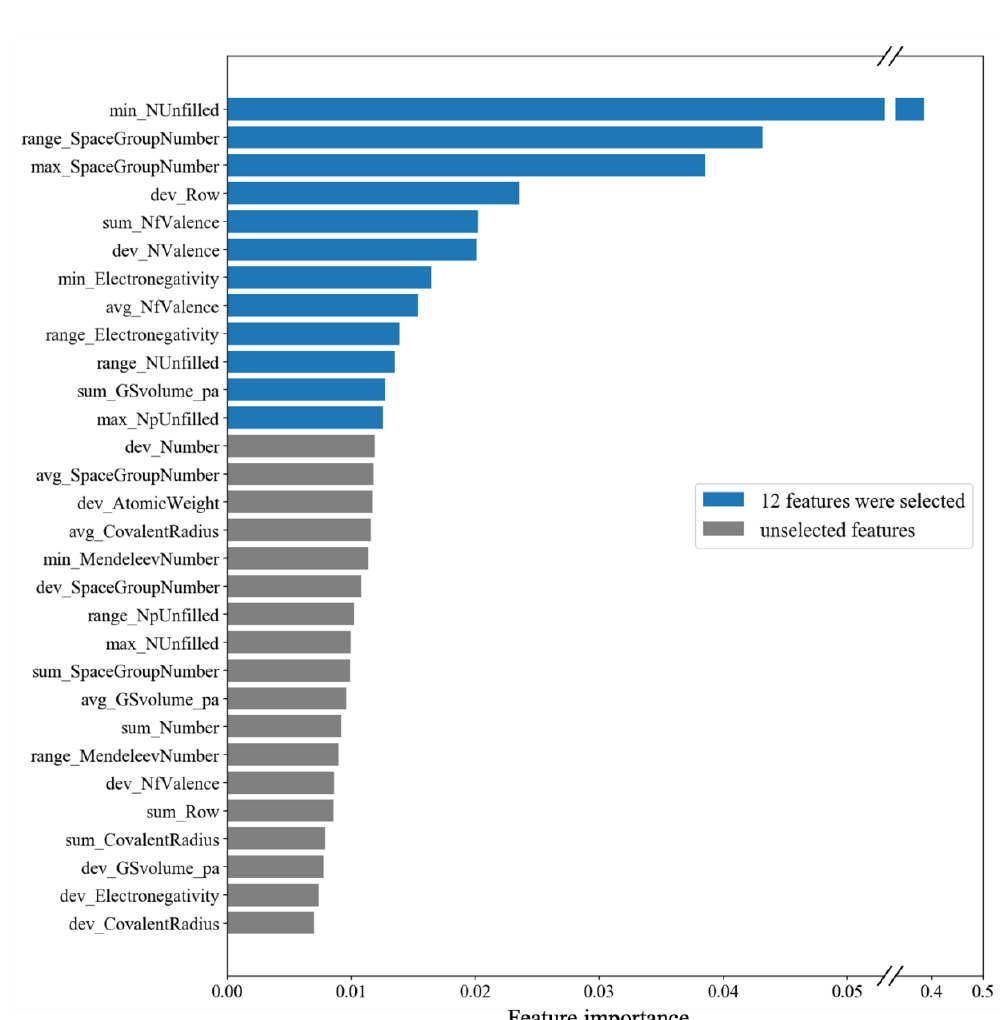
Figure 5. Exported features from the ML model, ranked according to their importance. The first 12 features are: 1. min_NUnfilled = minimum of total number of unfilled valence orbitals of the elements in the material (Bi 1-x A x CuSeO), 2. range_SpaceGroupNumber = range of space group of T= 0 K ground state structure of the elements, 3. max_ SpaceGroupNumber = maximum of space group of T = 0 K ground state structure of the elements, 4. dev_Row = deviation of row on periodic table of the elements, 5. sum_NfValence = summation of number of filled f valence orbitals of the elements, 6. dev_NValence = deviation of total number of valence electrons of the elements, 7. min_Electronegativity = minimum of Pauling electronegativity of the elements, 8. avg_NfValence = average of number of filled f valence orbitals of the elements, 9. range_Electronegativity = range of Pauling electronegativity of the elements, 10. range_NUnfilled = range of total number of unfilled valence orbitals of the elements, 11. sum_GSvolume_pa = DFT volume per atom of T = 0 K ground state, 12. max_NpUnfilled = maximum of number of unfilled p valence orbitals of the elements.